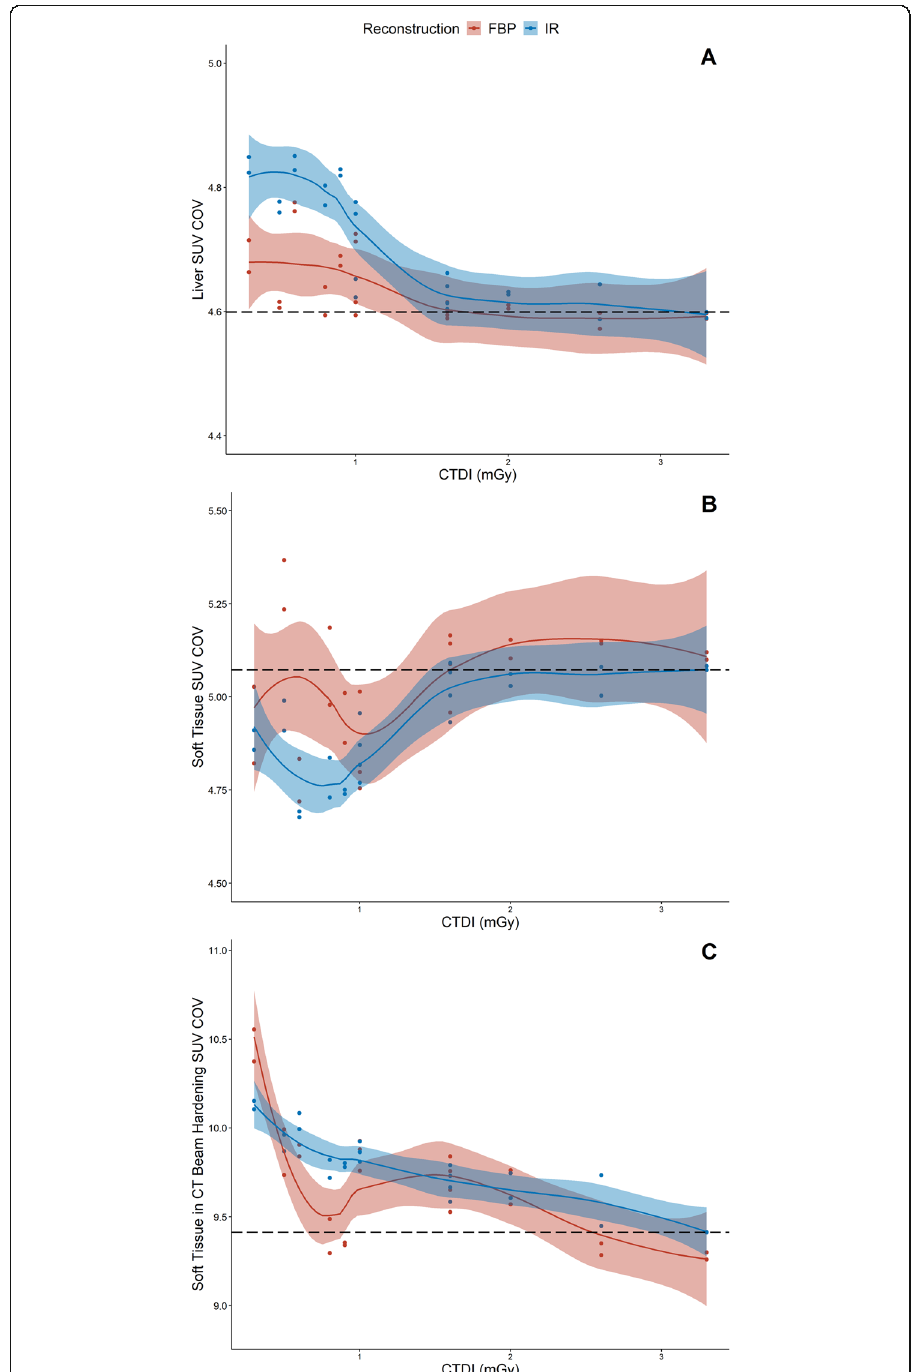
Fig. 3 SUV COV compared to CTDI for each reconstruction of the ROIs in the liver ( a ), soft tissue ( b ) and soft tissue in CT beam hardening ( c